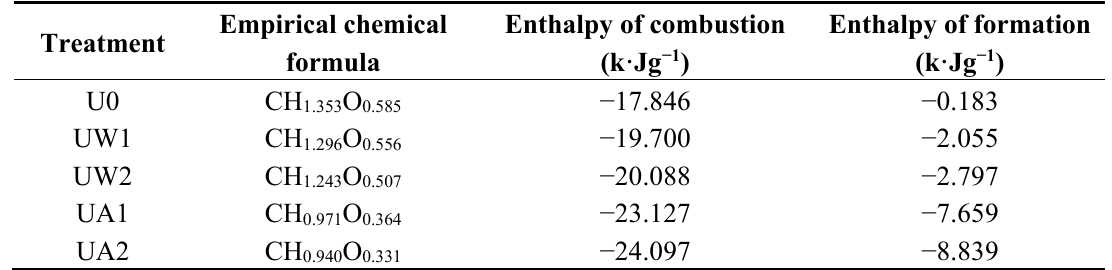
Table 5. Chemical formula, enthalpy of combustion and enthalpy of formation in HTC without and with diluted acid.